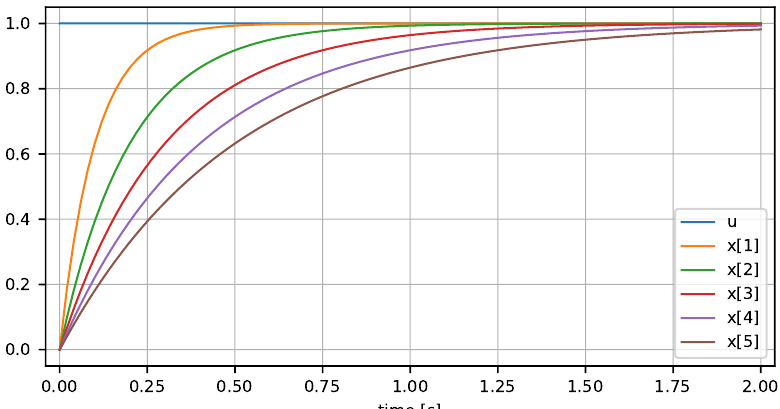
Figure 5. Parameter variation of model firstOrder with T = 0.1,0.2,0.3,0.4,0.5, k = 1.0, u ( t ) = 1.0, and x 0 =